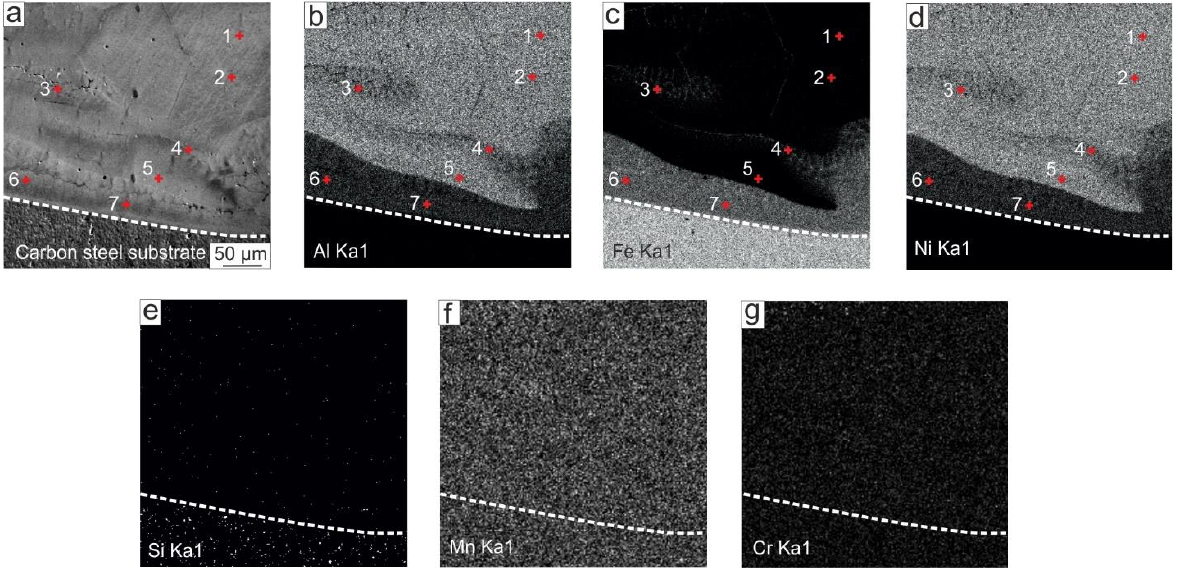
Figure 6. EDX analysis of NiAl-based coating near the steel substrate: ( a ) SEM image; ( b – g ) EDX maps showing the distribution of elements. The numbers in Figure ( a ) indicate the points for EDX analysis. The composition of the points is presented in Table 4. Table 4. EDX analysis at local points in Figure 6a.